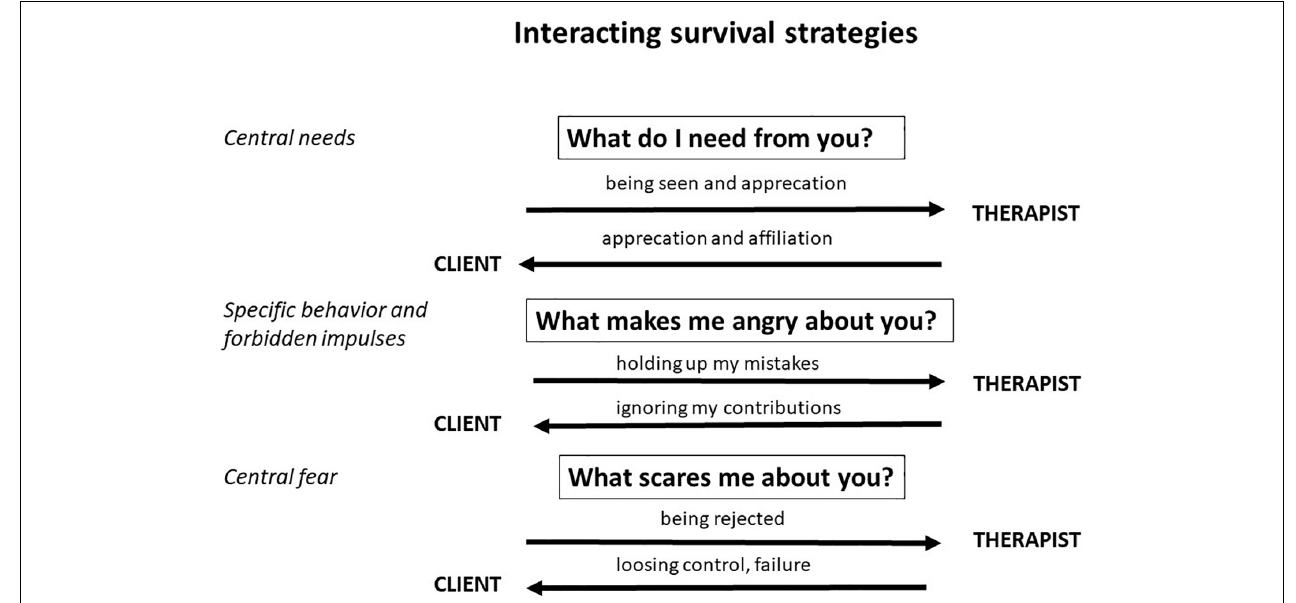
FIGURE 3 | Interacting survival strategies between Julia and her